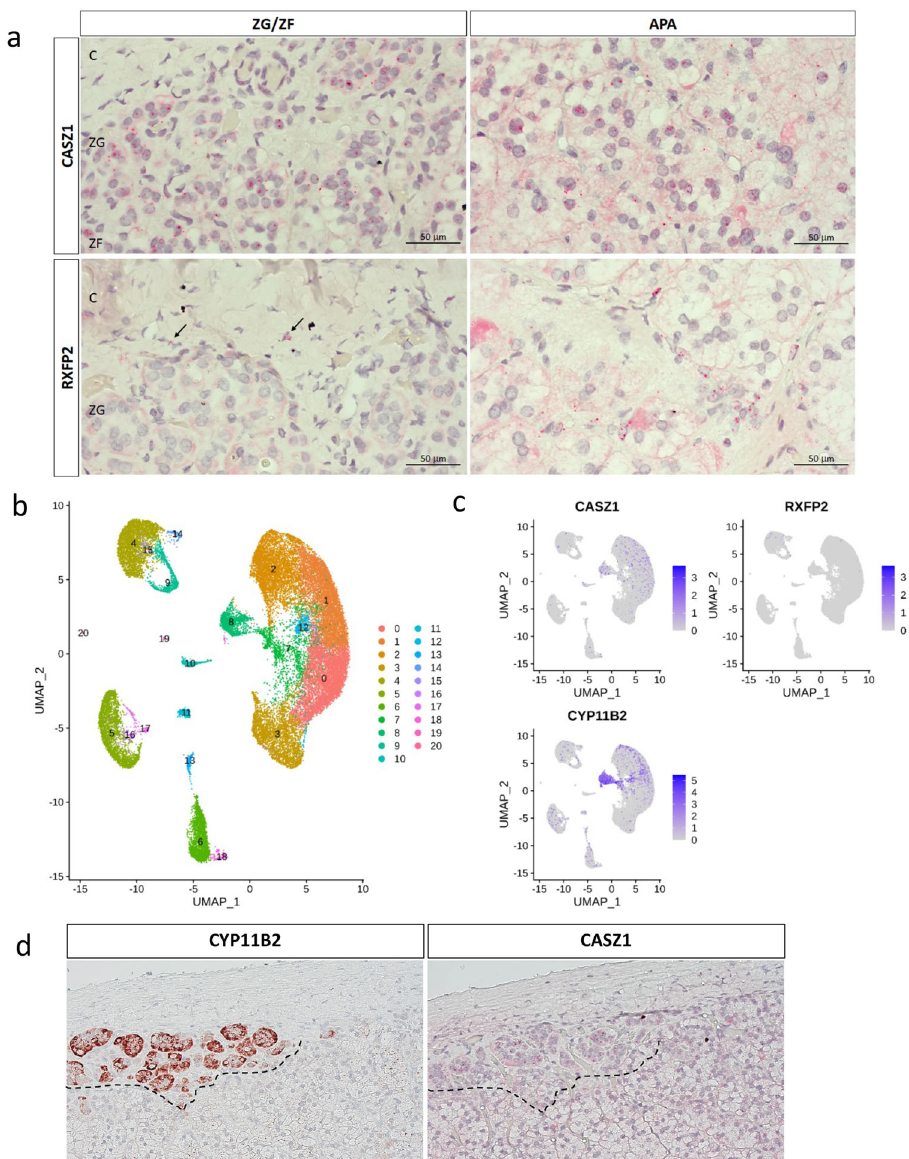
Fig. 3 | Expression of CASZ1 and RXFP2 in the adrenal cortex and APA. a CASZ1 and RXFP2 mRNAlocalizationintheadrenalcortexofanadrenalwithAPAcarrying a somatic KCNJ5 mutation analyzed by RNAscope. Red dots represent positive staining. Images are representative of results obtained in adrenals from four patients. C capsule,ZGzona glomerulosa,ZFzona fasciculata. b Uniform Manifold Approximation and Projection (UMAP) diagram from snRNA-seq from 5 pieces of adrenal cortex adjacent to APA from two adrenals; cells are colored by 1 – 20